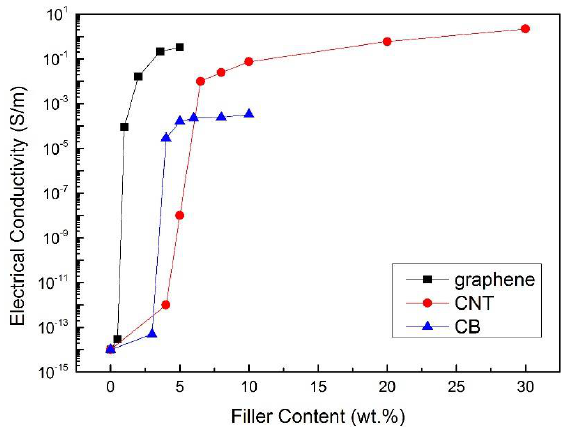
Figure 5. Electrical conductivity of nanoparticle/epoxy hybrid versus weight percentage of nanofiller content.